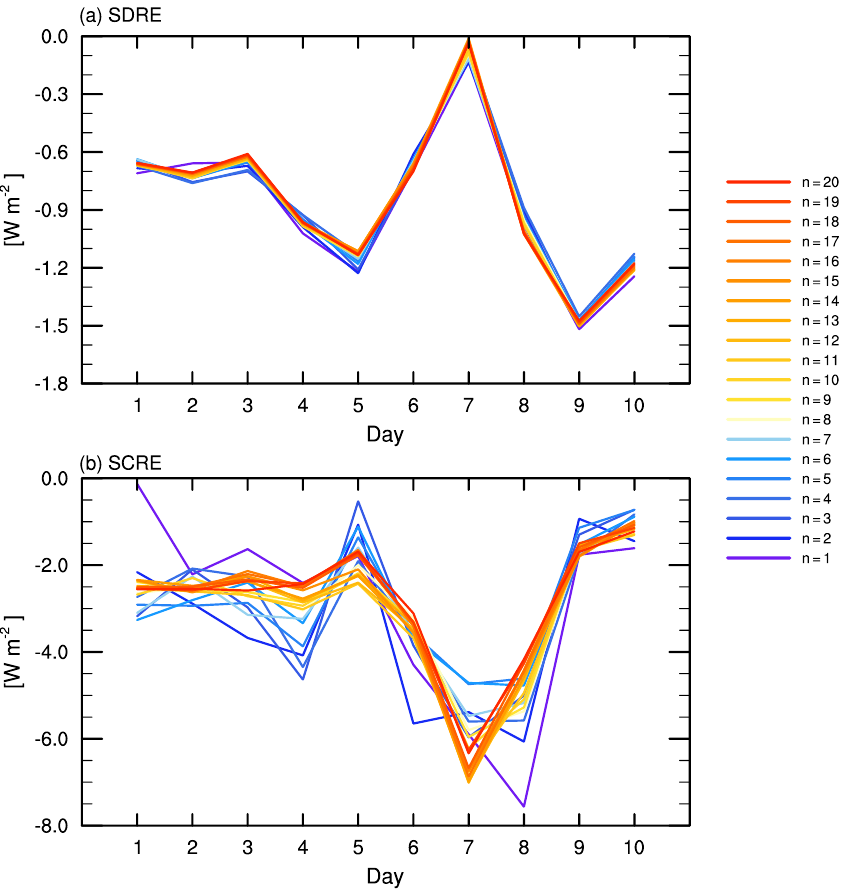
Figure 14. Time series of daily ensemble mean fire aerosol (a) SDRE and (b) SCRE averaged over southern Mexico during 1–10 April 2009 in QFED-forced ensemble simulations with varying total ensemble member numbers ( n = 1–20).